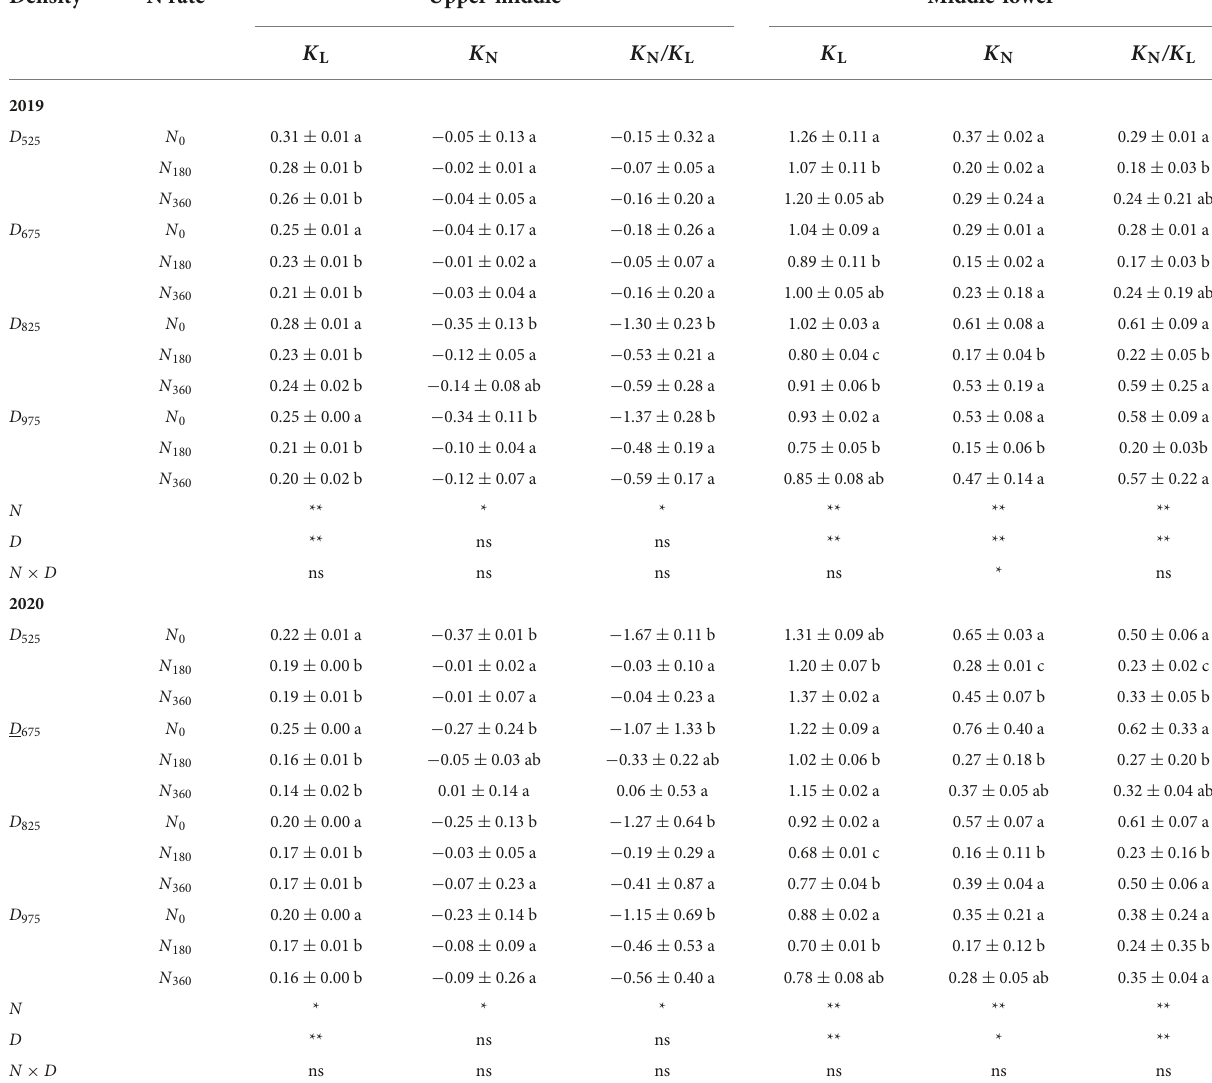
TABLE 3 Influence of N rate and plant density on the canopy light extinction coefficient ( K L , m 2 ground m − 2 leaf), canopy nitrogen extinction coefficient ( K N , m 2 ground m − 2 leaf), and their ratio ( K N /K L